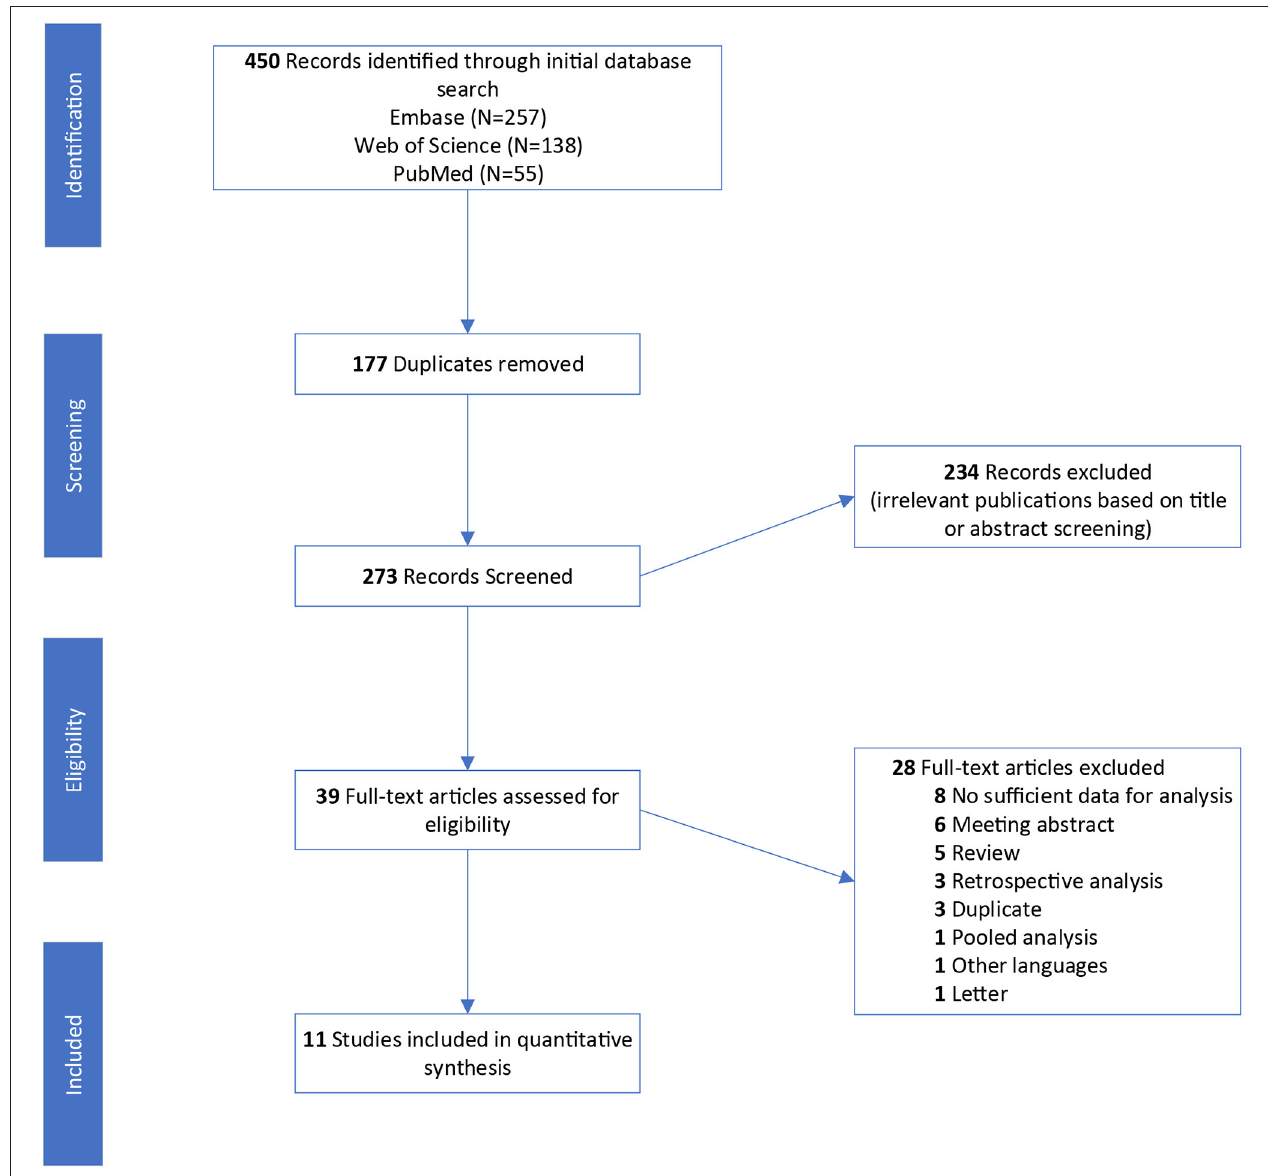
FIGURE 1 | Flow diagram of the study selection